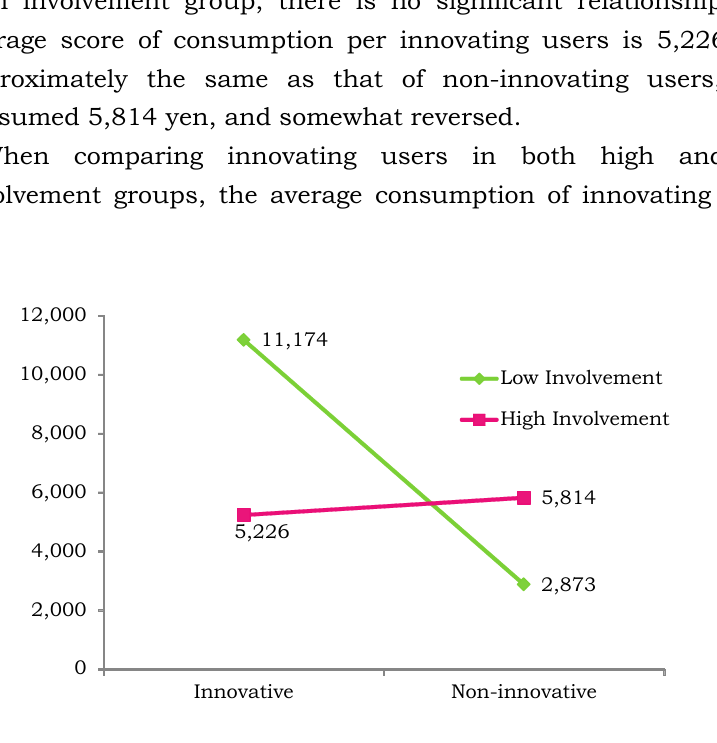
Figure 2. Involvement and consumption